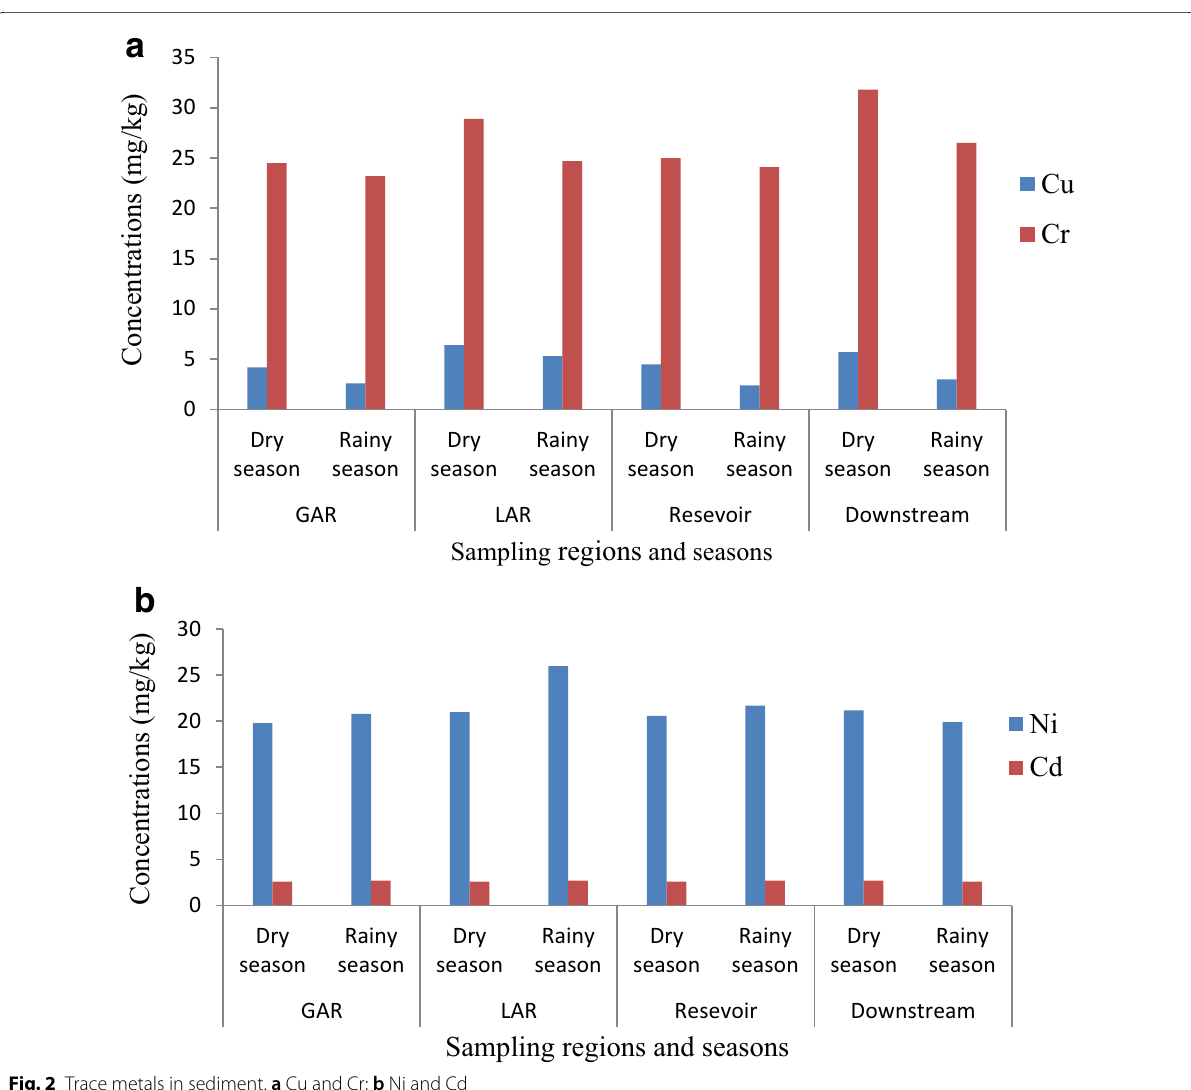
Fig. 2 Trace metals in sediment. a Cu and Cr; b Ni and